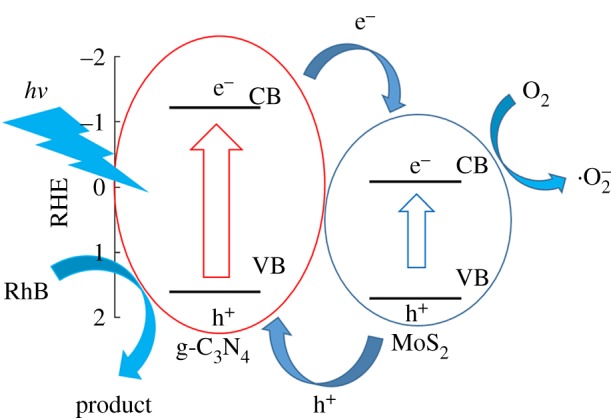
Schematic illustration of charge carrier transformation in the g-C3N4/MoS2 heterojunction.